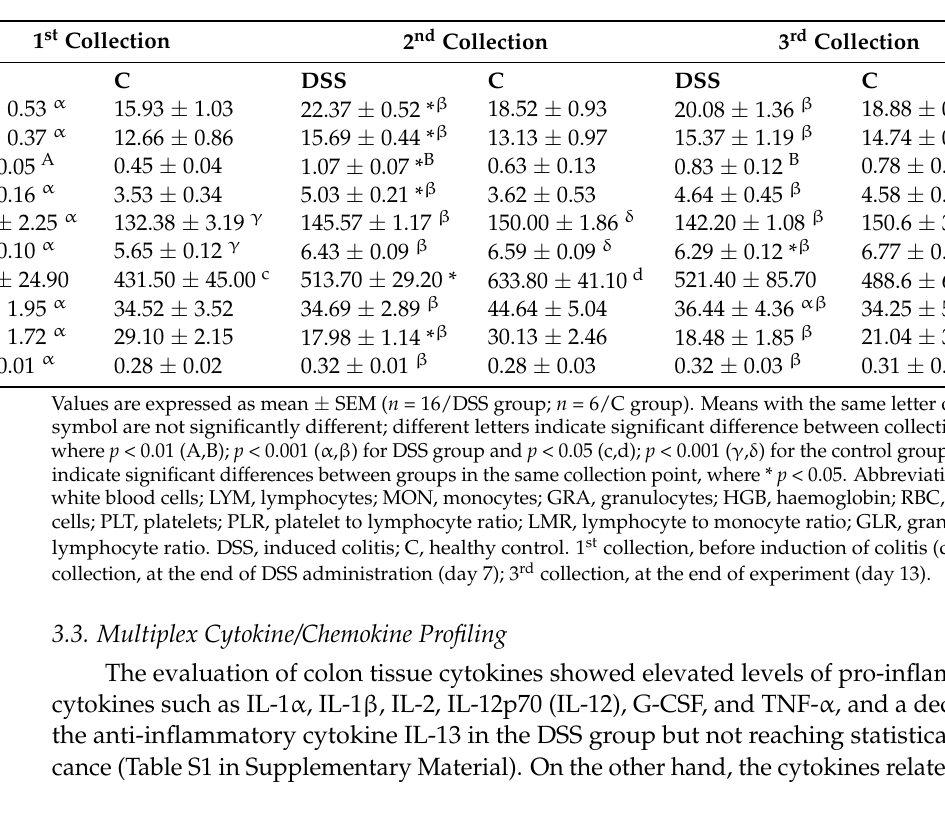
Table 4. Haematological